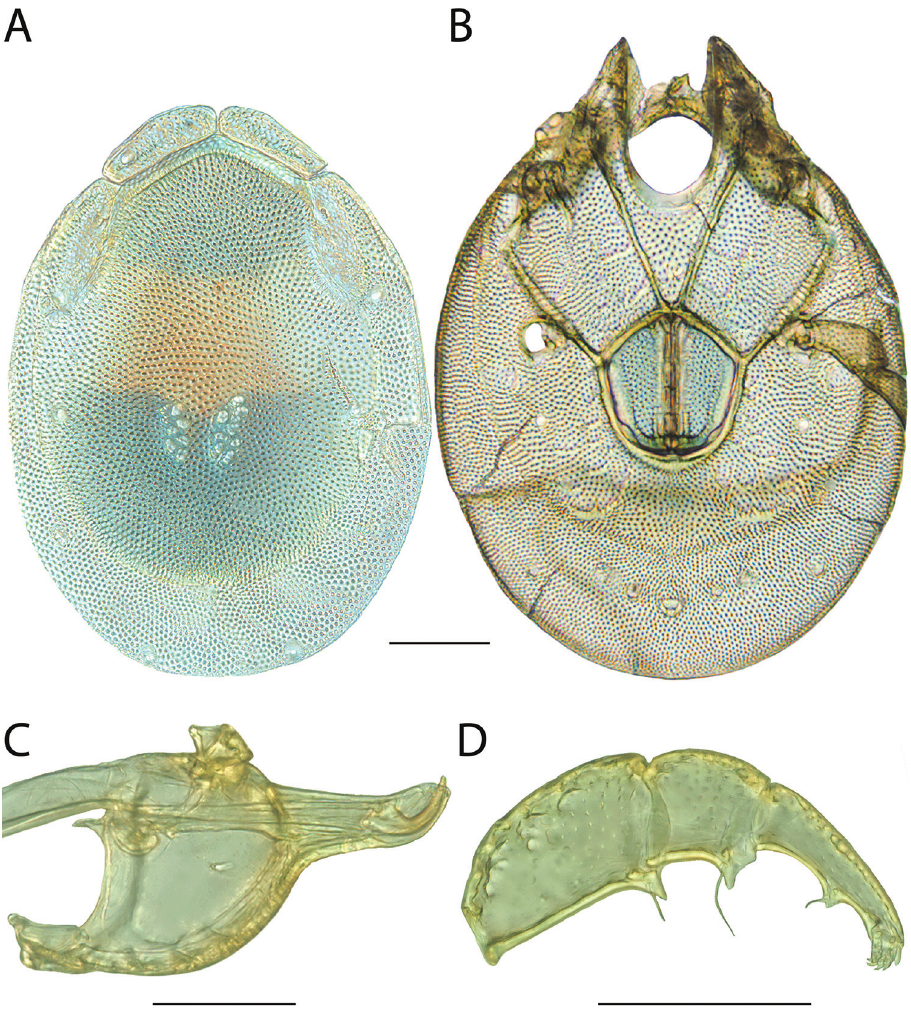
Figure 138. Torrenticola malarkeyorum sp. n. female: A dorsal plates B venter (legs removed) C subca- pitulum D pedipalp (setae not accurately depicted). Scale = 100